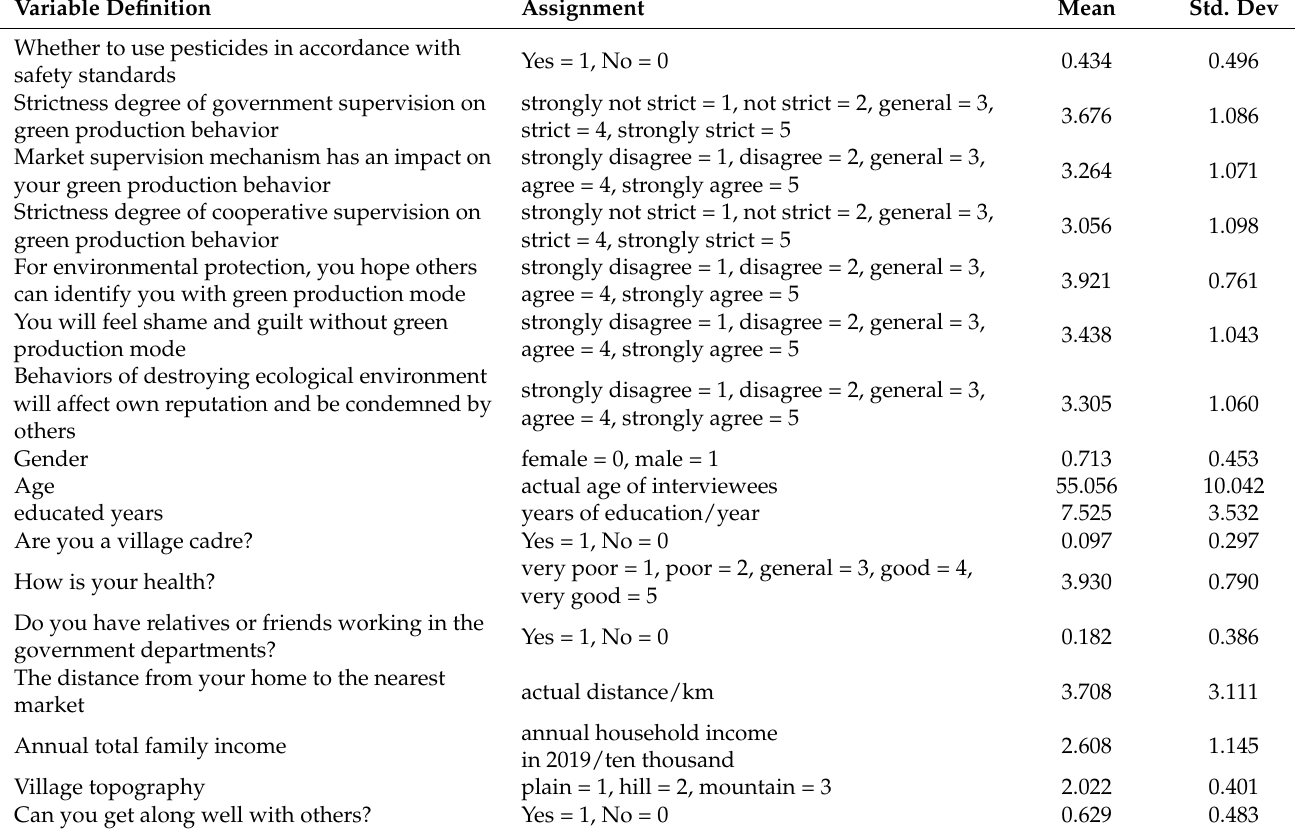
Table 2. Variable definition and descriptive